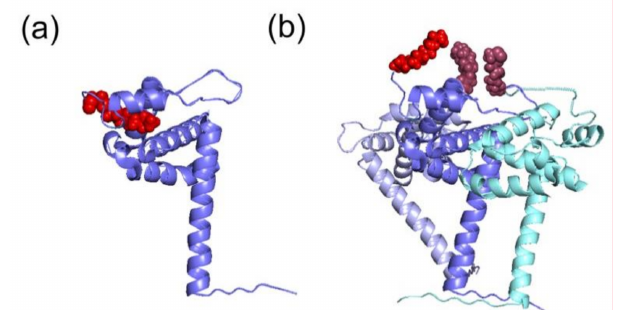
Figure 3. Different structural conformations of HIV-1 MA monomer or trimer. The tertiary structures of the MA domain in the different conformations of the switch look similar. ( a ) The MA domain in its monomeric conformation (in blue) displays a sequestered myristoyl group (in red) (PDB: 1UPH [36]). ( b ) Representation of the trimer of MA (in blue, light blue and cyan) and the corresponding exposed myristoyl groups (in red). This model was proposed according to which the myristoyl group is exposed in the multimeric form, thus allowing its interaction with PM (adapted from